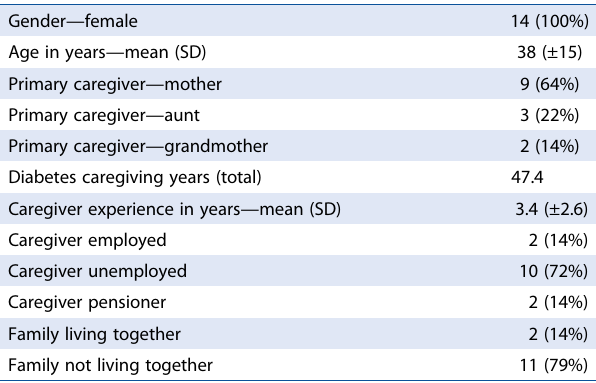
Table 1: Caregiver characteristics ( n = 14) Gender — female 14 (100%) Age in years — mean